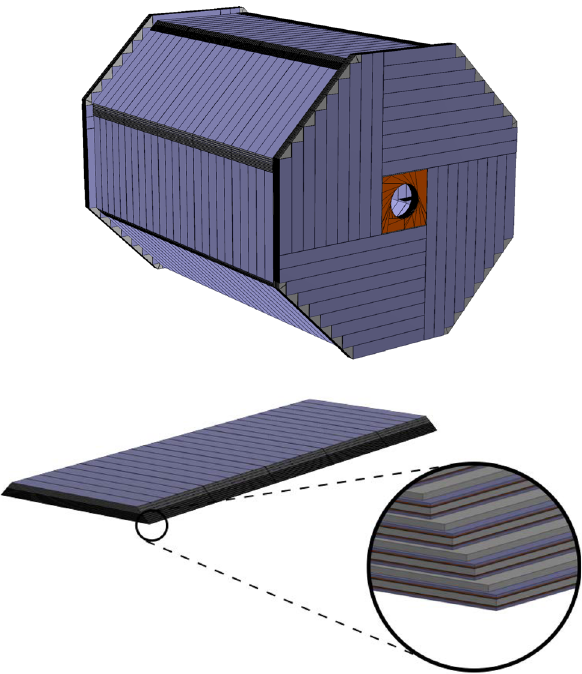
Fig. 2 Geometry of the CEPC ECAL (top) and a display of one ECAL stave [16] (bottom)